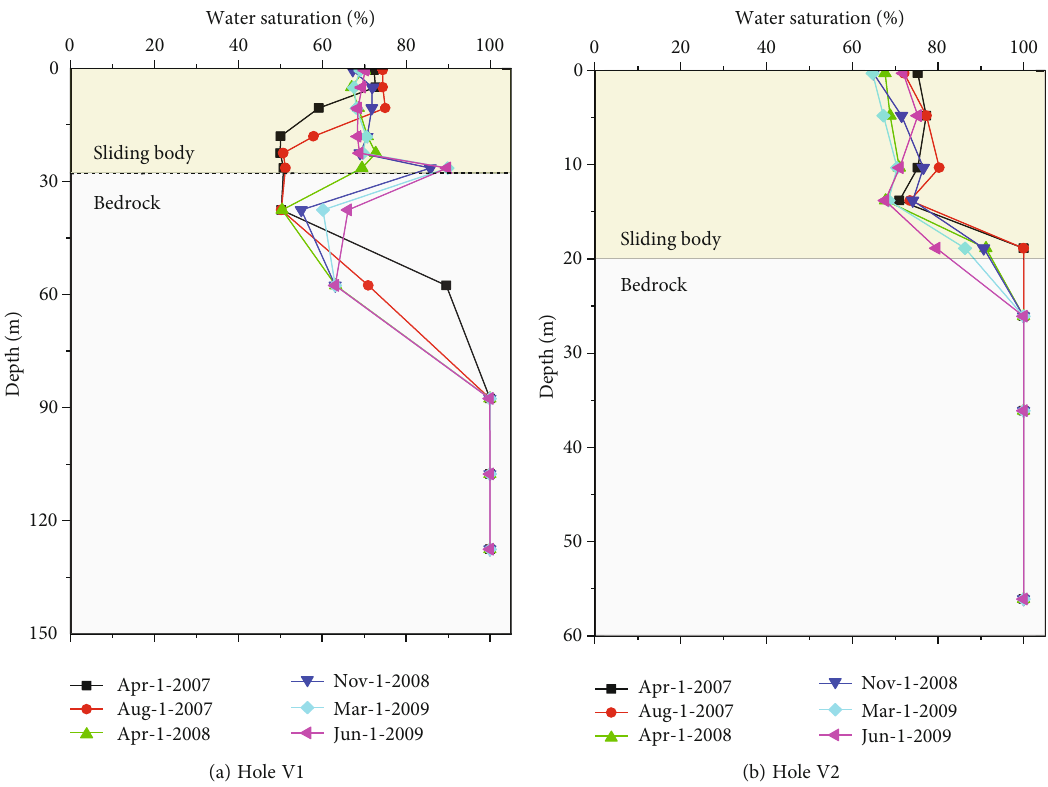
Figure 8: Water saturation versus depth at di ff erent